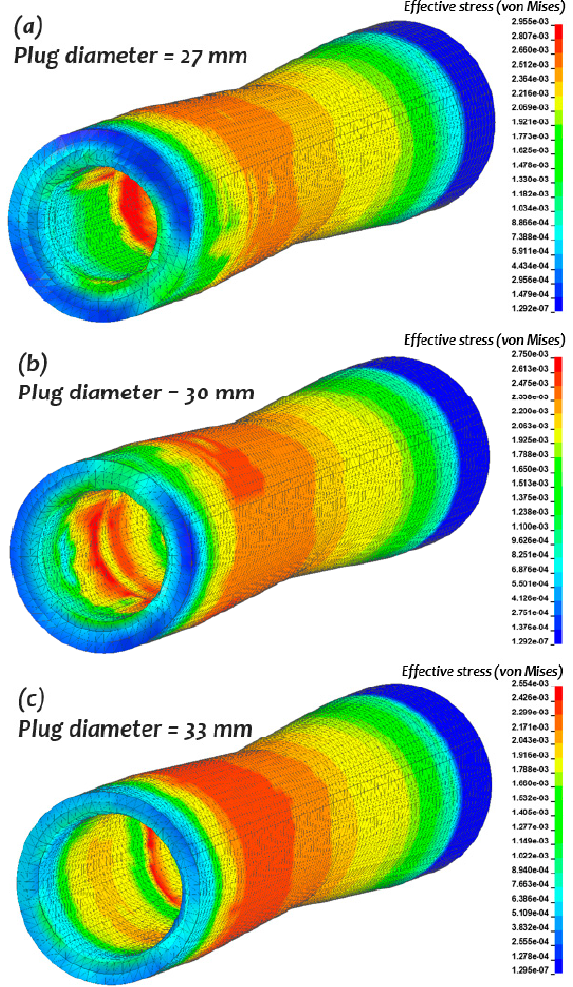
Figure 13. Rotary piercing with different maximum plug diameters with ( a ) plug diameter = 27 mm, ( b ) plug diameter = 30 mm, ( c ) plug diameter = 33 mm.